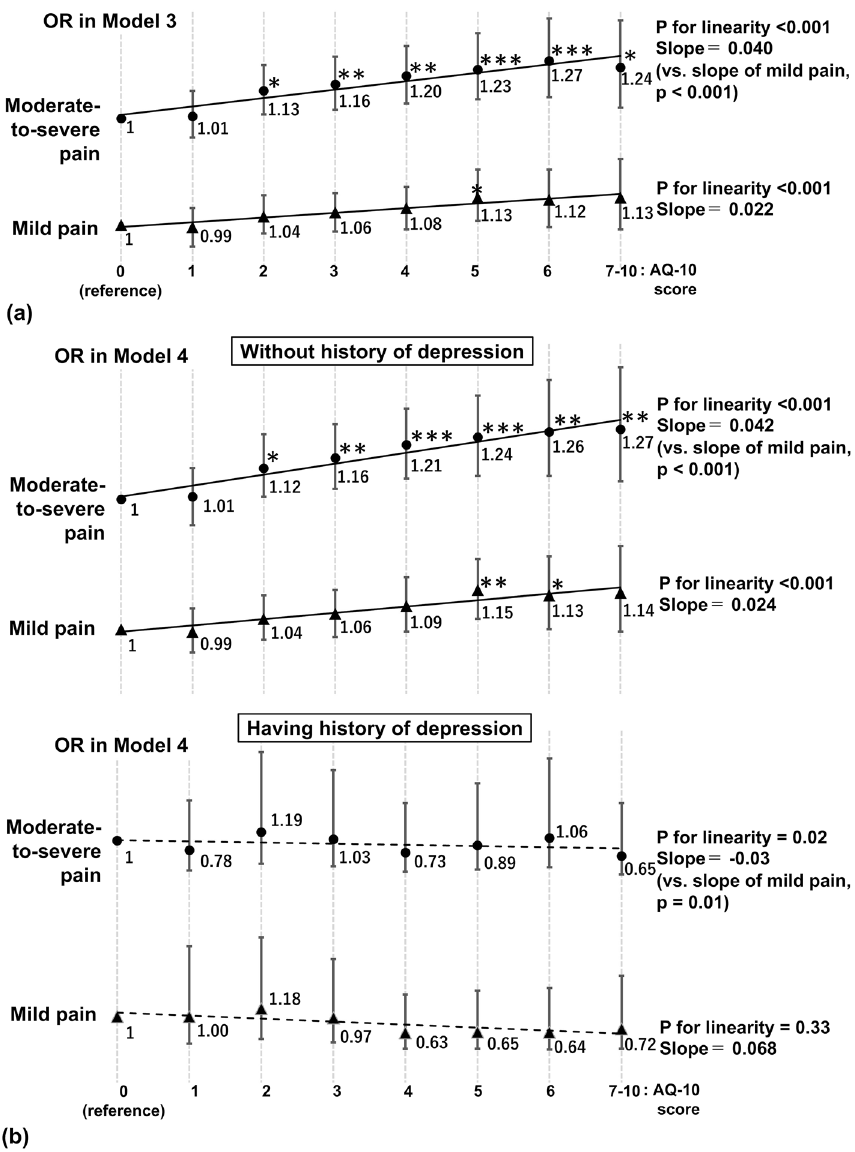
Figure 1. Enrollment process. Expectant mothers in the first trimester were recruited from January 2011 to March 2014. Two surveys were conducted; the first survey was conducted during the first trimester of pregnancy, and the second survey during the second to third trimester. AQ-10-J Autism-Spectrum Quotient short form-Japanese